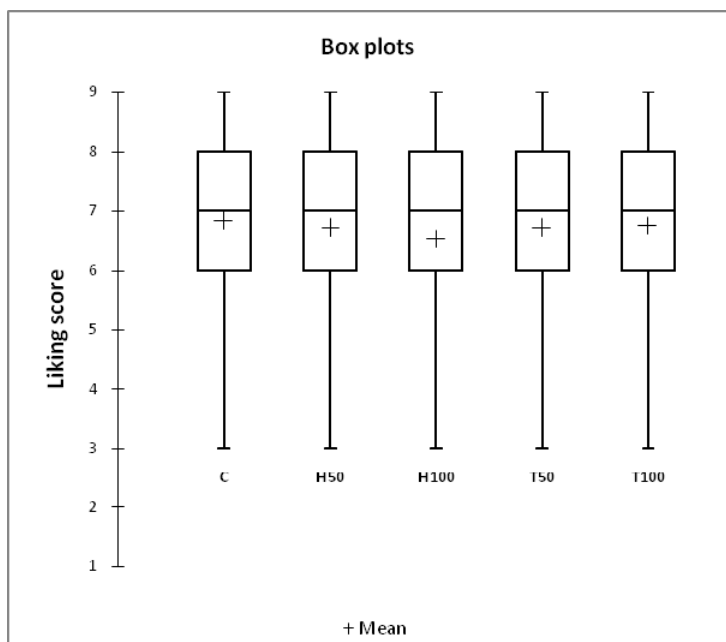
Figure 1. Box-plots for the overall acceptability: Evaluation on a nine-point hedonic scale. Note: C = control diet; H = Hermetia illucens fat; T = Tenebrio molitor fat. The horizontal axis represents the five dietary treatments, and the vertical axis represents the like score values. The crosses correspond to the means. The central horizontal bars are the medians. The lower and upper limits of the boxes are the first and third quartiles, respectively. The ends of the vertical lines or “whiskers” indicate the minimum and maximum like scores.